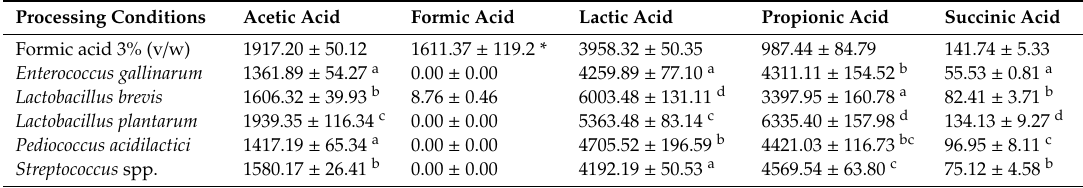
Table 7. Yields (mean value ± standard deviation, expressed in mg organic acid / 100 g sample ) ( n = 3) of organic acids in acidified and fermented spray-dried gibel carp ( Caracius gibelio ) silages of 3 weeks. In the fish silages, the acidic conditions were obtained by adding formic acid 3% (v / w), whereas the fermentation were carried out by independent inoculations with pure cultures of distinct lactic acid bacteria (LAB).